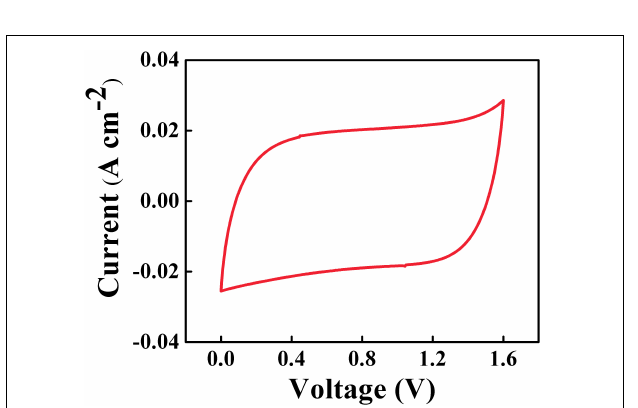
FIGURE 8 | (A) CV at scan rate of 10 mV s − 1 and (B) C s and C m vs. scan rate for PPy-MWCNT composite.